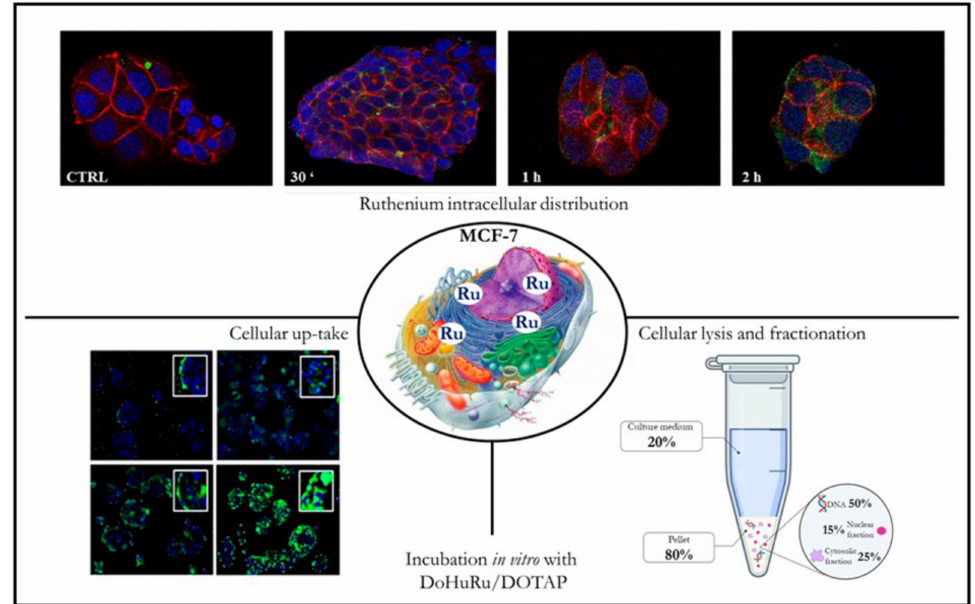
Figure 4. Uptake, distribution, and bioaccumulation of the Ru(III) complex AziRu after incubation of MCF-7 cells with the cationic nanosystem DoHuRu / DOTAP. Cellular uptake and distribution were monitored by confocal microscopy and ad hoc designed fluorescently tagged analogs of DOTAP-based nanoformulations [78,130]. Localization and bioaccumulation of the Ru(III) complex were evaluated in MCF-7 cells and culture media by means of subcellular fractionation and inductively coupled plasma-mass spectrometry (ICP-MS) [78]. In the indicated fractions, ruthenium amounts are reported as percentage of the total ruthenium administered during